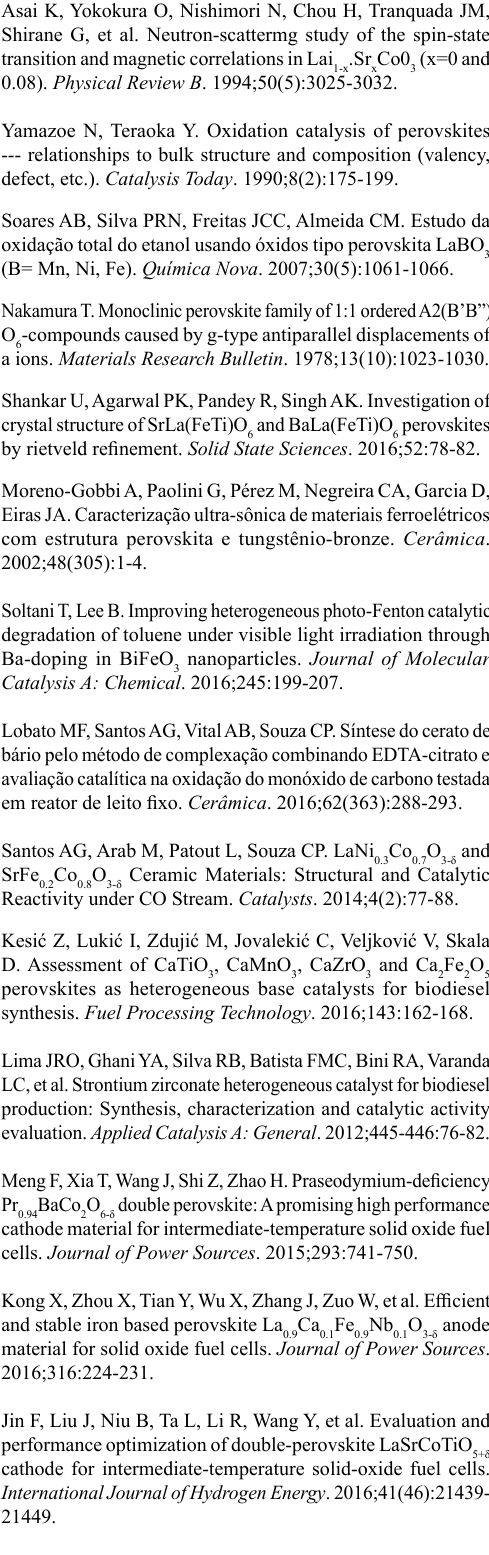
Figure 3. SEM images of BaCe (B): pH 3, (C) and (D): pH 7, (E) and (F): pH